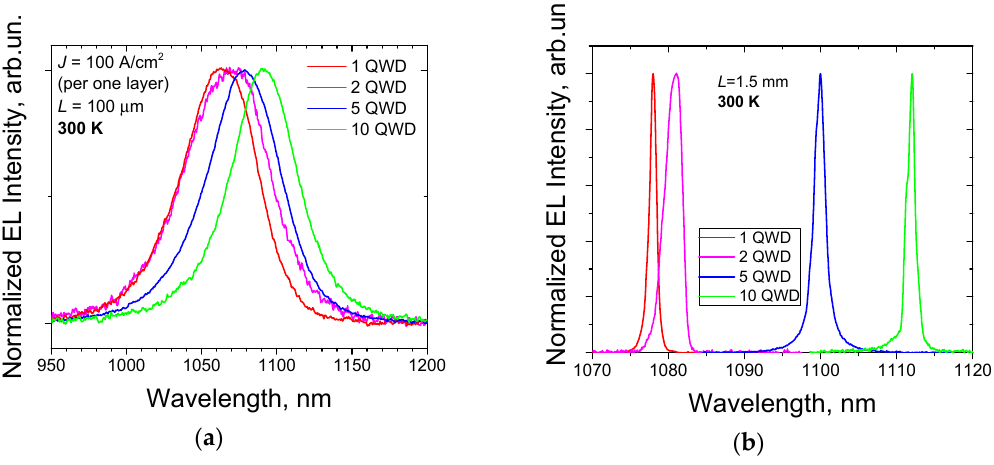
Figure 11. Below-threshold electroluminescence ( a ) and lasing ( b ) spectra of the lasers with different numbers of QWD layers.